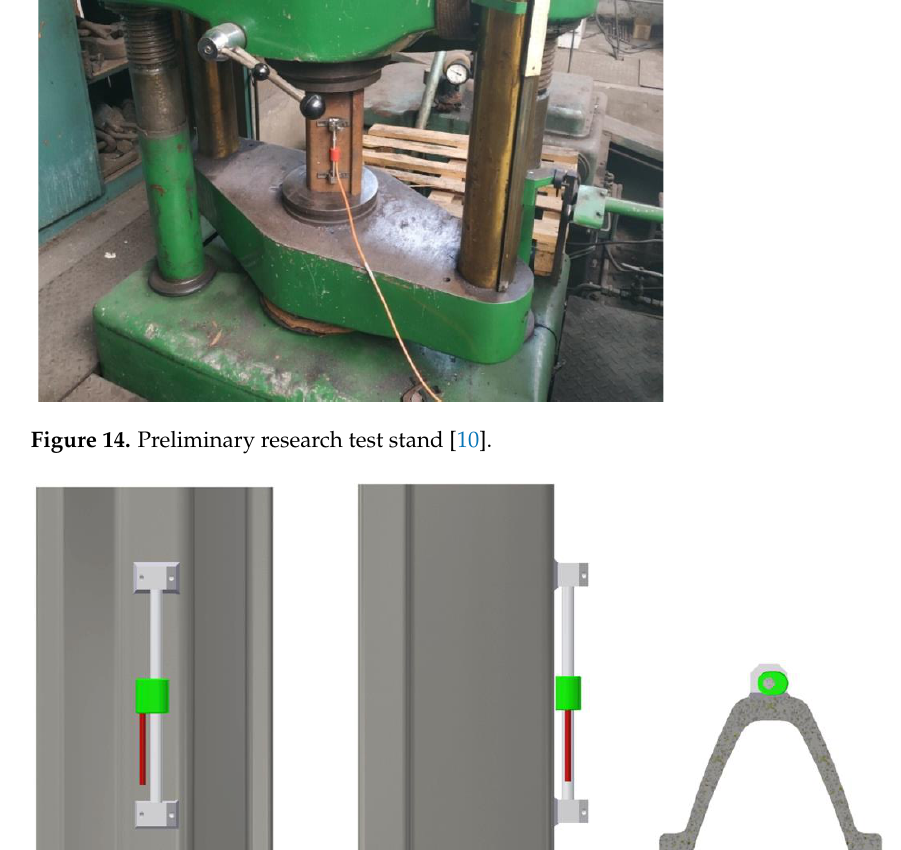
Figure 14. Preliminary research test stand [10].